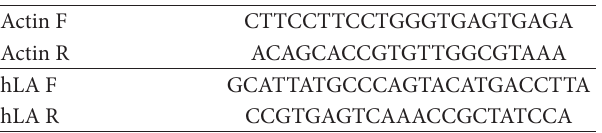
Table 2: The primers for actin and hLA.